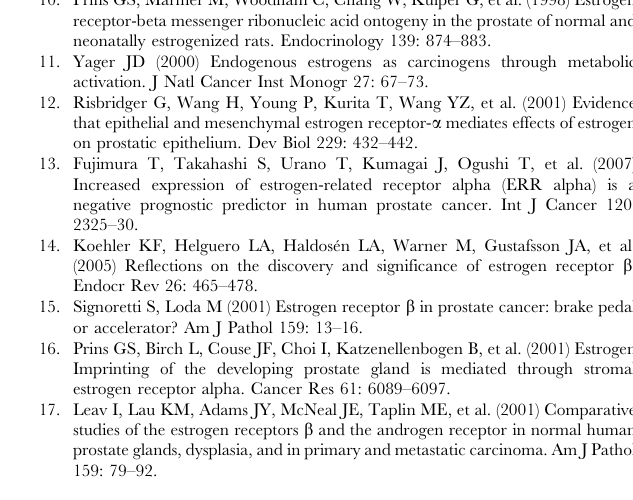
Table S2 Observed estrogen receptor SNP frequency in CLUE controls and SNP500/dbSNP data by